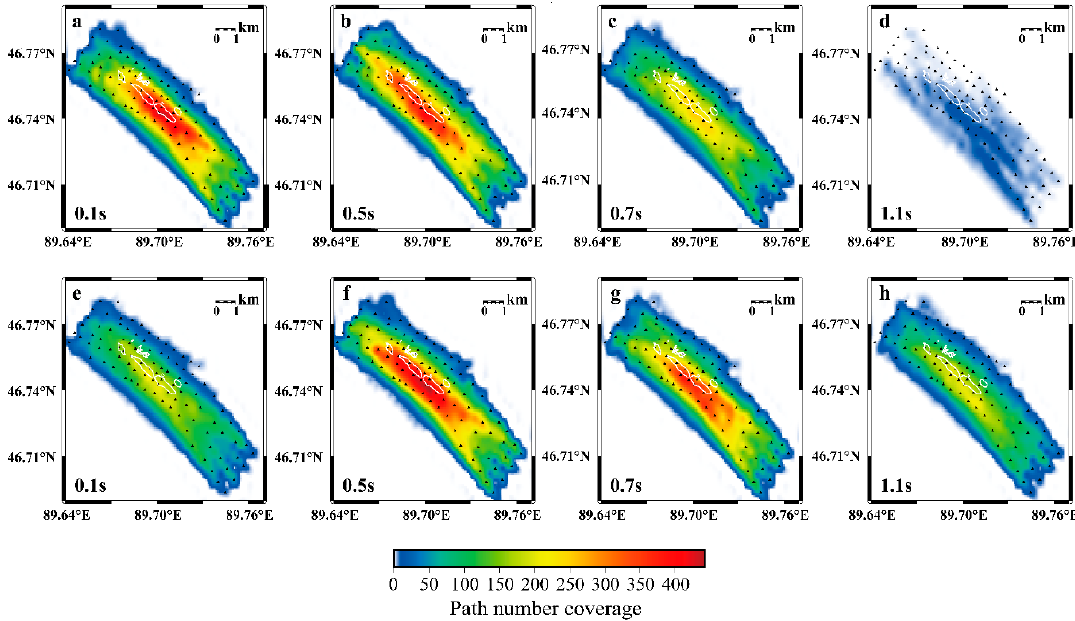
Figure 4. Ray path density maps of Rayleigh wave dispersion curves between all stations at various periods, and 0.1 s, 0.5 s, 0.7 s, 1.1 s are presented, respectively. ( a – d ) Ray path density maps of phase velocity; ( e – h ) Ray path density maps of group velocity.